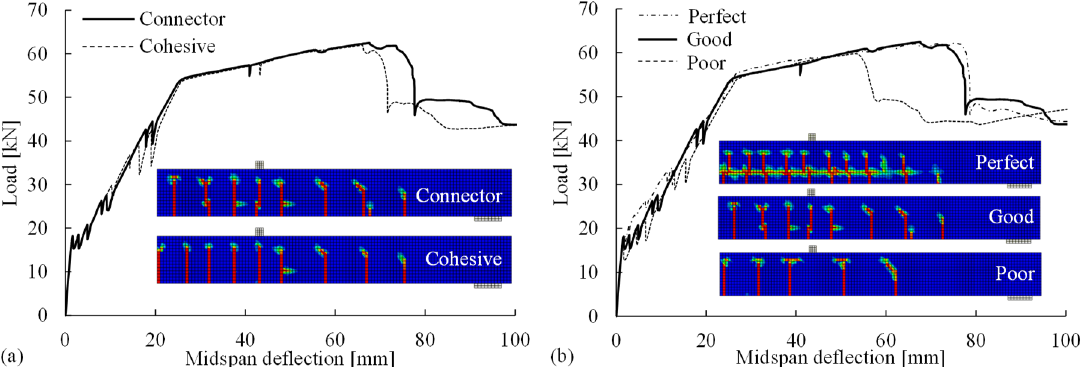
Figure 17. Comparisons of ( a ) methods for assigning the steel-concrete bond and ( b ) bond–slip behaviors based on the numerical results for the load–deflection relations and crack patterns.